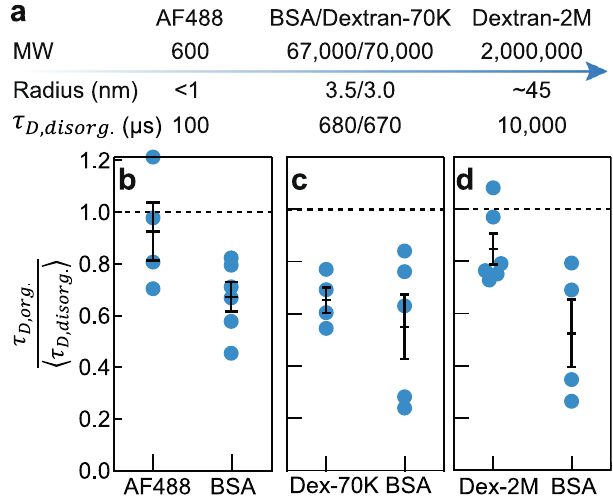
Fig. 4 | Organized cytoplasm optimizes short-range diffusion of protein-sized molecules. a Molecular sizes of probes used in this study. b – d Normalized diffu- sion times of Alexa Fluor 488 dye (AF488), dextran-MW70,000 (Dex-70K), and dextran-MW2,000,000 (Dex-2M) in organized cytoplasmic extracts. These experiments focused on the border regions of the organized cytoplasm such that datacollected <10mincould bebettercompared.Eachpanelshowsdatafromtwo droplets of extracts prepared from a single batch of eggs; BSA diffusion was taken asastandardforcomparison.Errorbars,SEM. n =4,6,4,5,6,and4measurements of different positions in an extract for data from left to right, respectively. Source data are provided as a Source Data fi le.